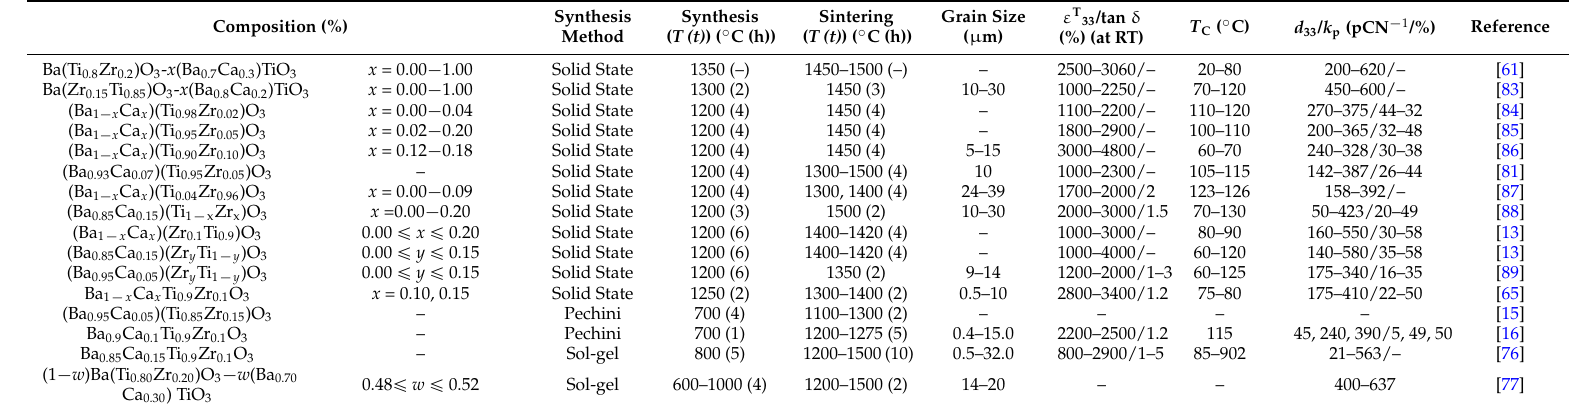
Table 1. Some results of the publications in the system BaTiO 3 -BaZrO 3 -CaTiO 3